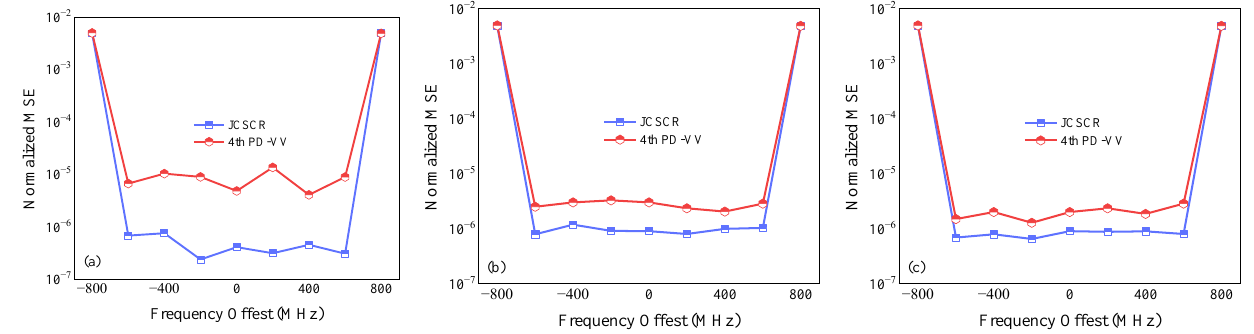
Figure 7. Normalized MSEs as functions of different frequency offsets: ( a ) 6.5 × 10 − 14 m − 2/3 , ( b ) 5 × 10 − 15 m − 2/3 , and ( c ) 6 × 10 − 16 m − 2/3 .